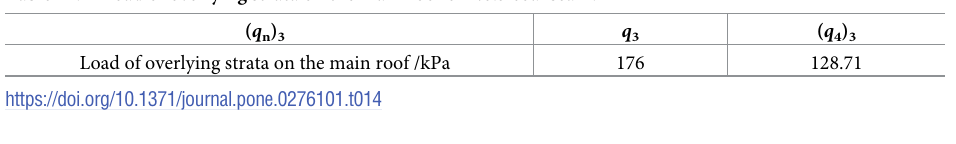
Table 13 shows the relevant parameters and information about the roof strata above No.5 coal seam. According to Eq (21), a load of overlying strata on the main roof of the No.5 coal seam can be calculated, as shown in Table 14. From Table 14, the load of the fourth stratum (in Table 14) on the third stratum (main roof, in Table 14) is less than the load of the second stratum itself, hence the fourth stratum is deemed as a key stratum. That means the fourth stratum has no load on the third stratum, which is q is 0kPa. In addition, the periodical weighting interval of the main roof of No.5 coal 0 seam is 23.35m calculated by Eq (5). Through Eqs (1), (2), (4), (21) and (30), the MSSC in the No.5 coal seam is 4015.3kN based on the calculation parameters in Table 15.